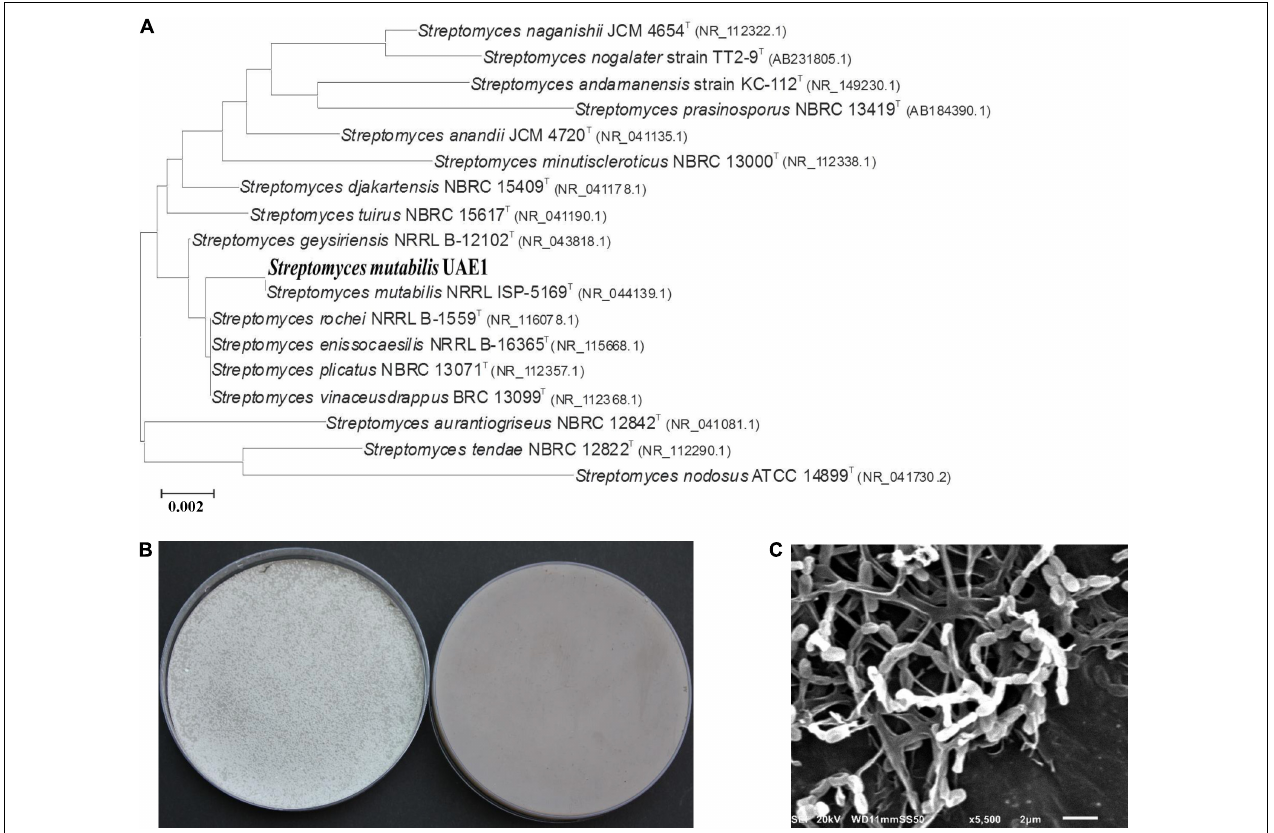
FIGURE 5 | Taxonomic determination of PA-producing Streptomyces mutabilis UAE1, based on phylogenetic, cultural, and morphological characteristics. (A) The tree showing the phylogenetic relationships between S . mutabilis UAE1 (isolate #24; MT883496; 1,520 bp) and other members of Streptomyces spp. on the basis of 16S rRNA sequences. (B) Aerial mycelia (left) and substrate mycelia (right) growing on ISP medium 3 supplemented with yeast extract, and (C) scanning electron micrograph (5,500) of spore chains and structure of S. mutabilis UAE1 which belonged to section spirales. In (A) , numbers at nodes indicate percentage levels of bootstrap support based on a maximum-likelihood analysis of 1,000 resampled datasets. PA, polyamine. Bar, 0.002 substitutions per site. GenBank accession numbers are given in